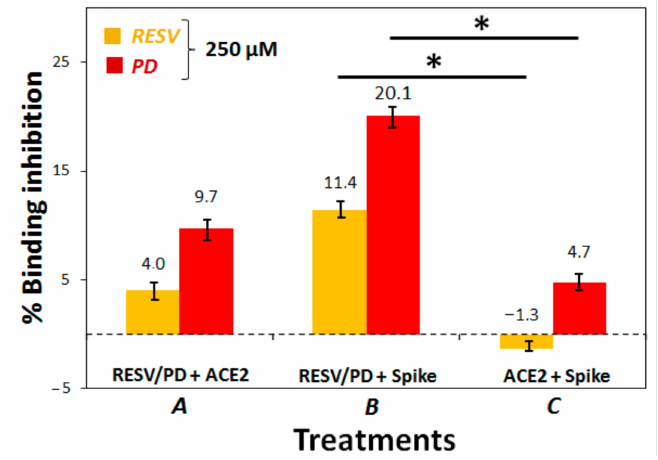
Figure 5. ACE2:Spike inhibition binding assay. In Treatment A, the polyphenols were pre-incubated with ACE2 on the plate, and then Spike was added; in Treatment B, the polyphenols were pre- incubated with Spike in solution, and this mixture was then added to ACE2 on the plate; in Treatment C, ACE2 and Spike were pre-incubated on the plate and then the polyphenols were added. Per- centages of binding inhibition were calculated correlating the chemiluminescence intensity readings (Figure S9) to that of the positive control. p -Values have been calculated using the Student’s t -test (* p ≤ 0.05).